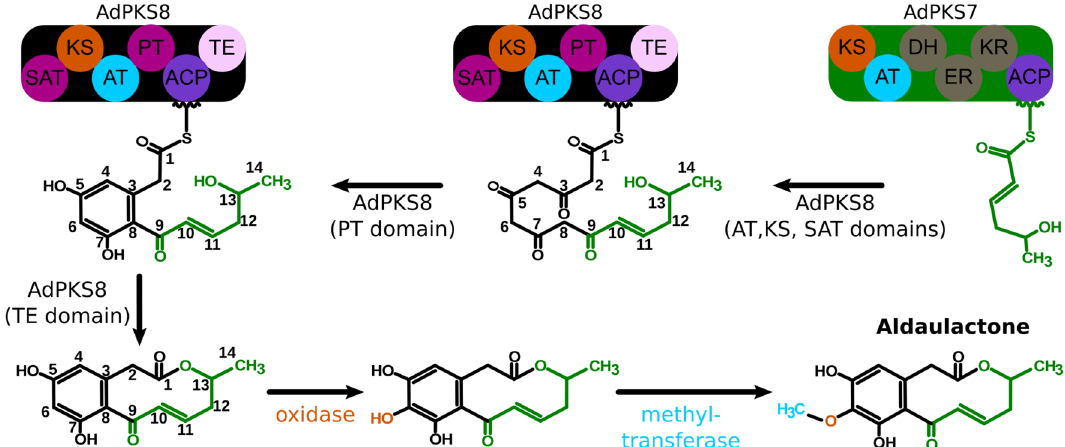
Figure 9. Proposed biosynthetic pathway of aldaulactone in A. dauci . The HR-PKS (AdPKS7) produces a reduced triketide. This triketide becomes the starter unit of the NR-PKS (AdPKS8). AdPKS8 catalyzes the addition of four more malonyle-CoA units. The AdPKS8 PT domain catalyzes a C3–C8 aldol condensation. AdPKS8 TE domain then catalyzes the macrolactone cyclisation. Afterward, the cluster 8 oxidase catalyzes the addition of an alcohol function on C6 of the benzene diol. Finally, the methylation of the C6 alcohol function is catalyzed by the cluster 8 methyl